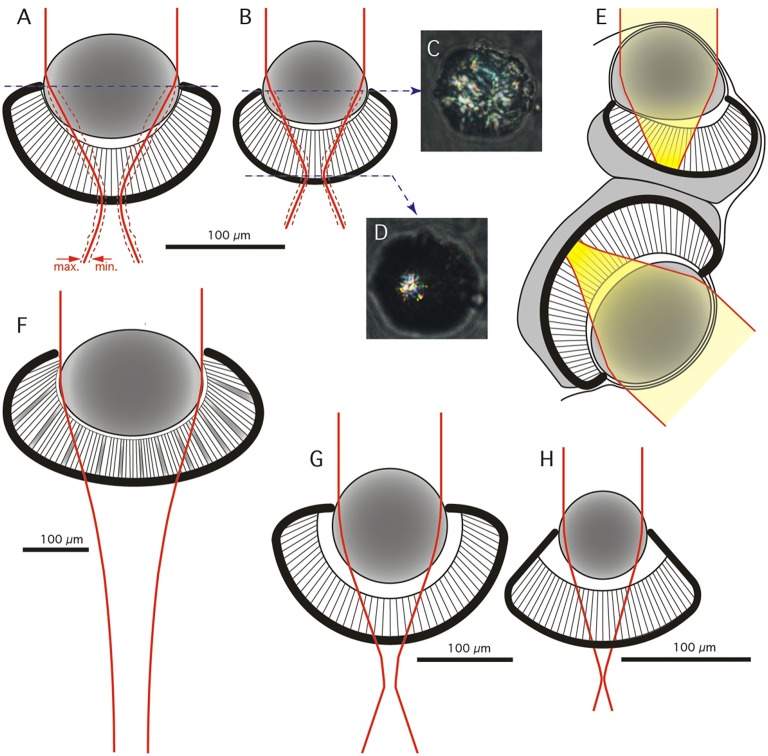
Geometrical model and optics of the lens eyes. (A,B) Frontal view of anatomical models of the lower (A) and upper (B) lens eye of C. sivickisi. Red line indicates average beam width of a distant point light source, broken red lines indicate maximum and minimum beam width (N = 5 in A and N = 3 in B). (C,D) Examples of the appearance of beam cross-sections behind a lens of the upper lens eye photographed at the lens equator and at the focal plane. (E) The average beam profilers from (A,B) plotted in the sagittal plane of the rhopalium. The yellow field highlights beam width for a point source and thus the blur spot in the retina. (F) Optical model of the lower lens eye of Chiropsella bronzie for comparison (modified from O'Connor et al., 2009). (G,H) Optical models of the lower and upper lens eyes of Tripedalia cystophora respectively (modified from Nilsson et al., 2005).